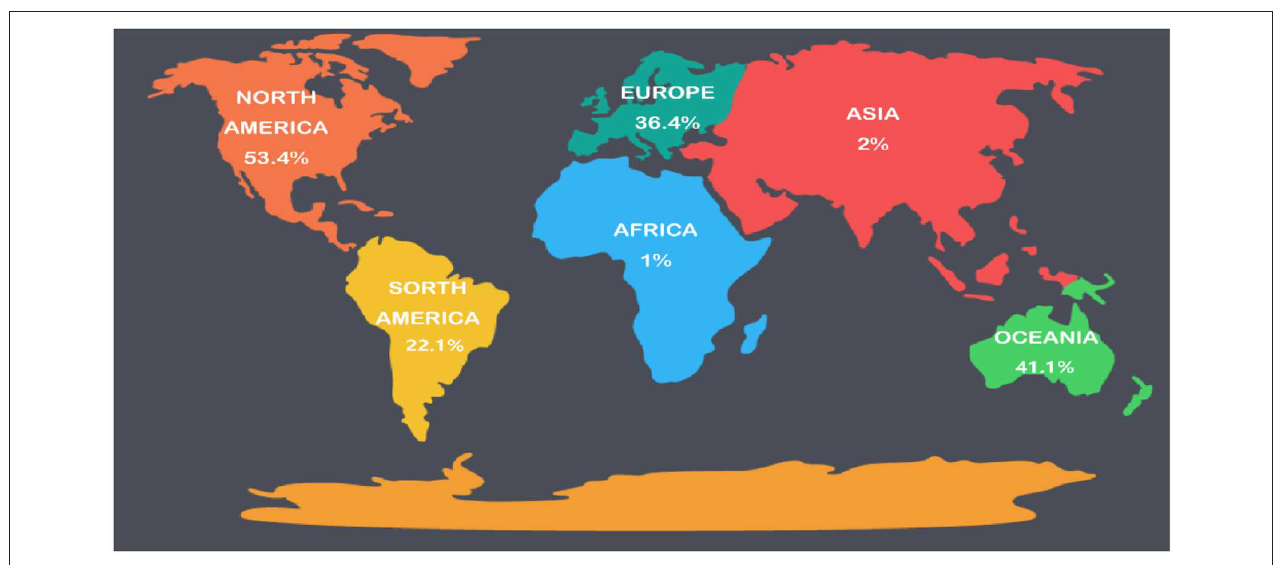
FIGURE 4 | Worldwide HPV vaccination rates. HPV, human